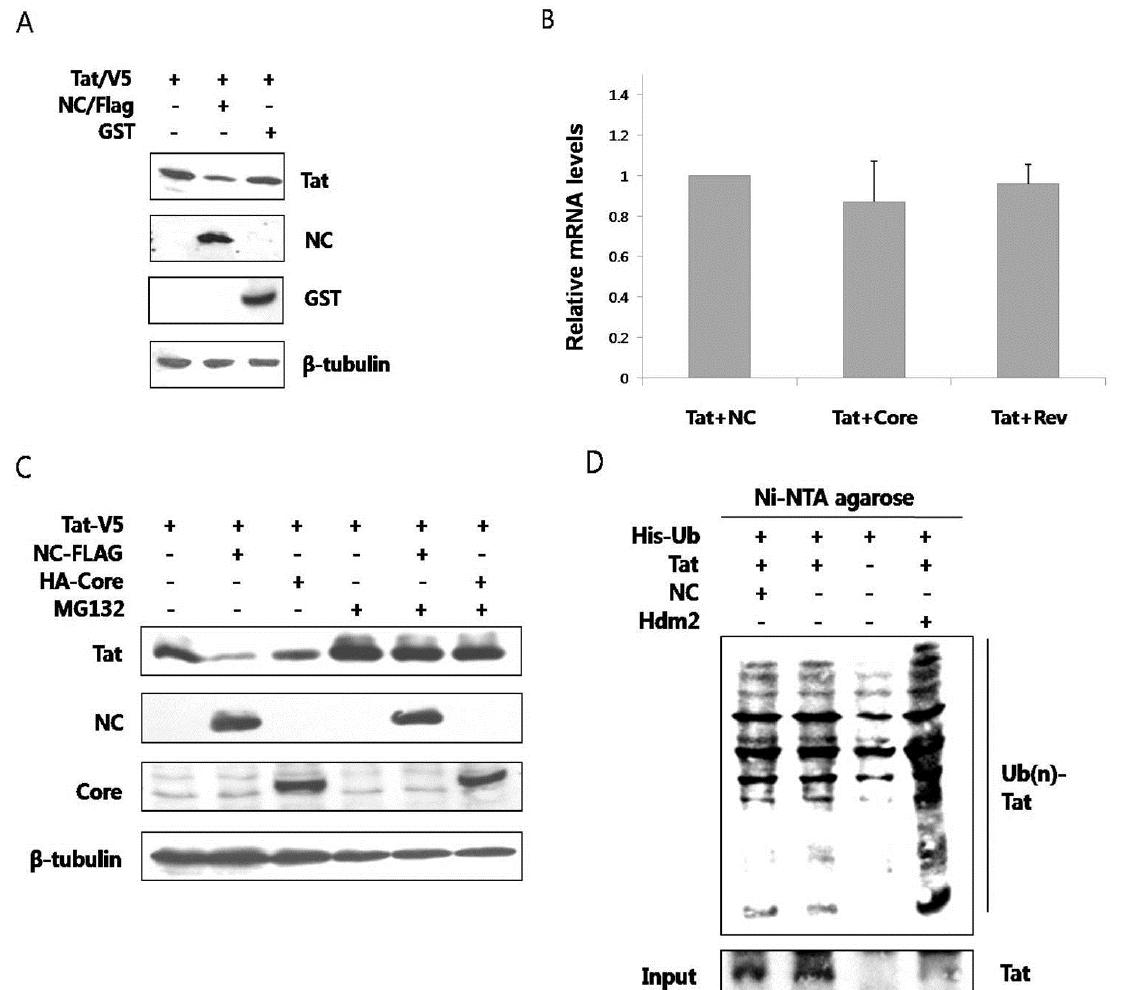
Figure 2. NC induced proteasomal degradation of Tat in an ubiquitin-independent